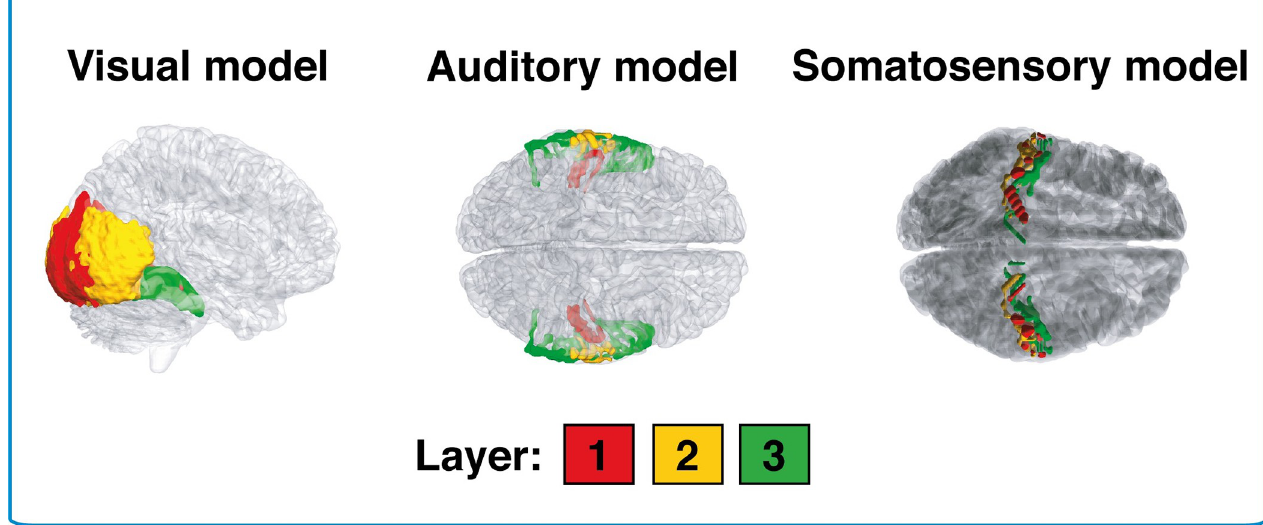
Fig 3. Perceptual hierarchies used for fMRI-based model analysis. Three different three-layer perceptual hierarchies were defined: a visual hierarchy, an auditory hierarchy and a somatosensory hierarchy. The visual hierarchy constitutes our model of interest, while the auditory and somatosensory hierarchies constitute control models. The regions chosen for layers 1, 2 and 3 are colored in red, yellow and green respectively. Precise details of the regions are specified in S1 Table.